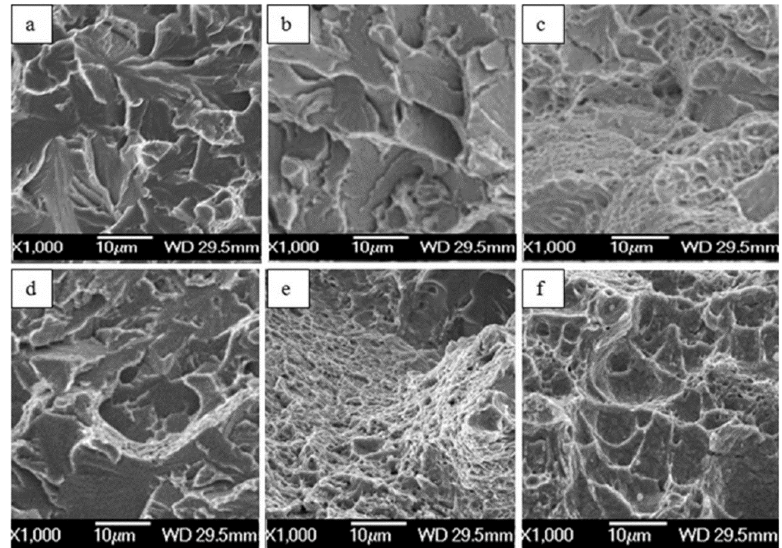
Figure 9. The fracture surface of N80-42CrMo4 Charpy V-notch test sample tested at the temperature of –50 °C, 20 o C, and 100 o C. a, b and c) As-welded, d, e, and f) Stress relief